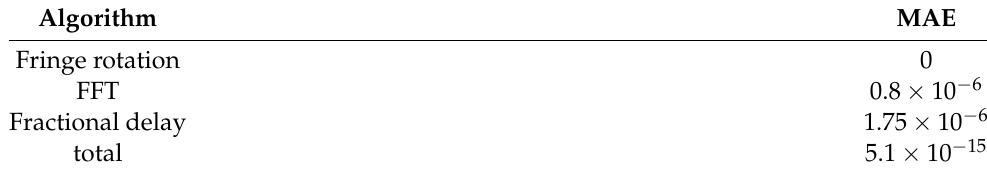
Table 6. Differences in calculation results between serial version and parallel